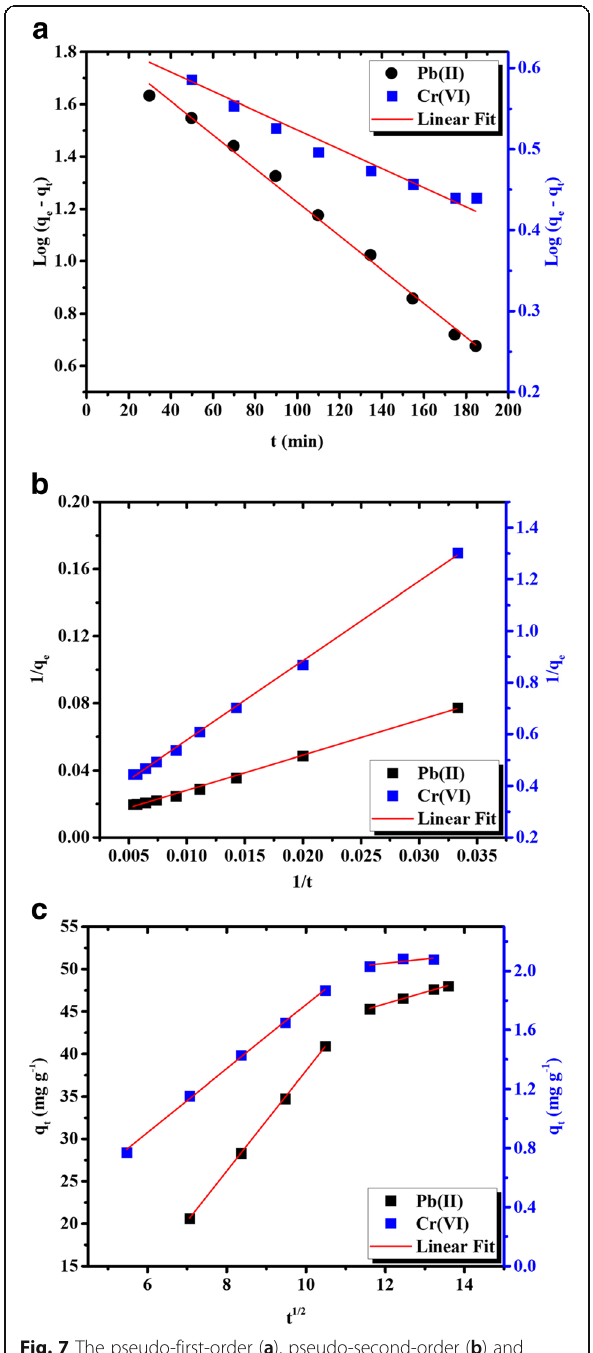
onto CSM/SA hybrid